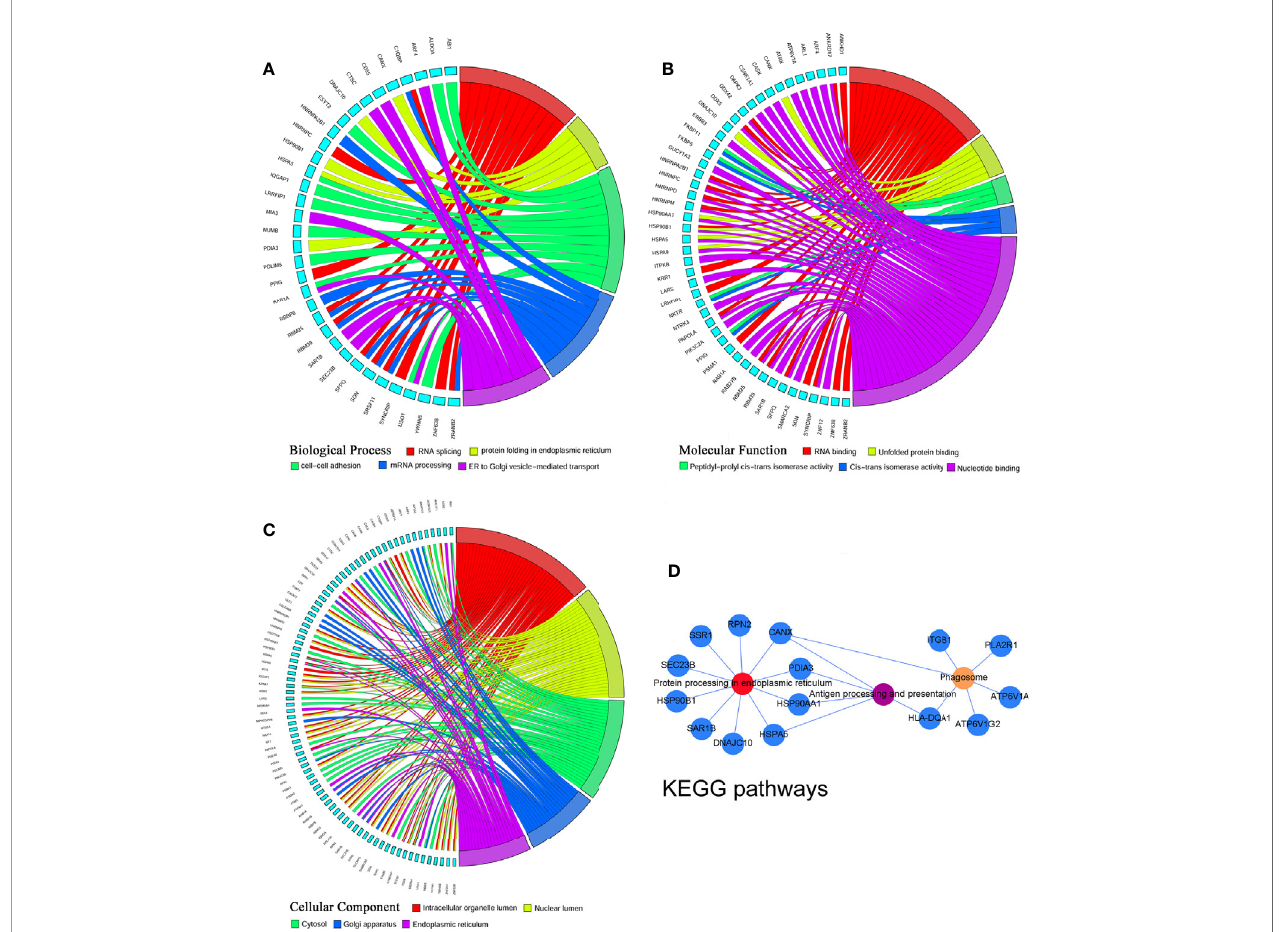
FIGURE 2 | Gene Ontology terms and Kyoto Encyclopedia of Genes and Genomes (KEGG) pathways of the common differentially expressed genes (DEGs) set. Circos plot represents the relationship between genes and the top 5 signi fi cant terms including biological process (A) cellular component (B) and molecular function (C) . Different colors from red, yellow, green, blue to purple indicate that the P values are sorted from minimum to maximum. (D) KEGG pathway analysis showed that DEGs were mainly enriched in pathways related to protein processing in endoplasmic reticulum, phagosome, and antigen processing and presentation. Different colors from red, yellow to purple indicate that the P values are sorted from minimum to